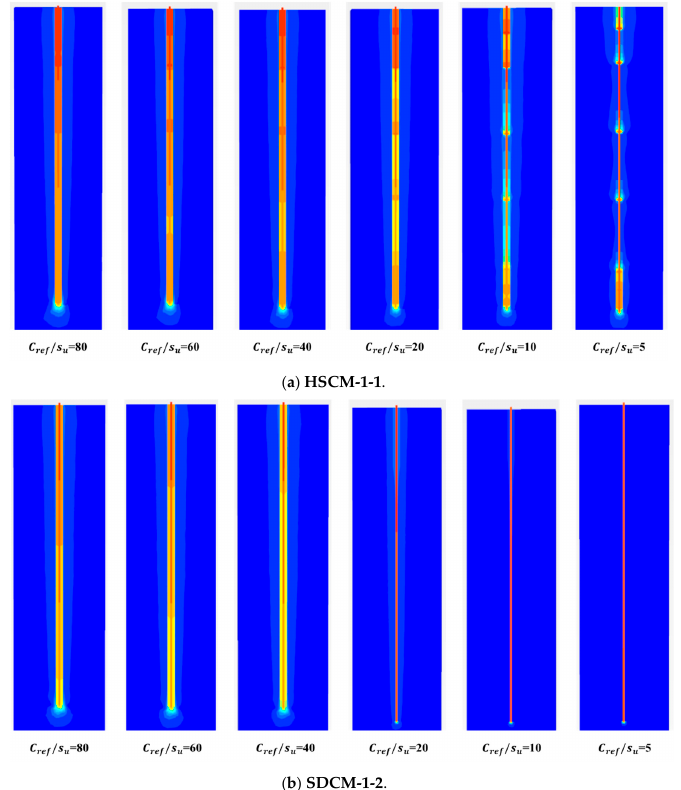
Figure 8. Calculated deformation results with different 𝑪 𝒓𝒆𝒇 /𝒔 𝒖